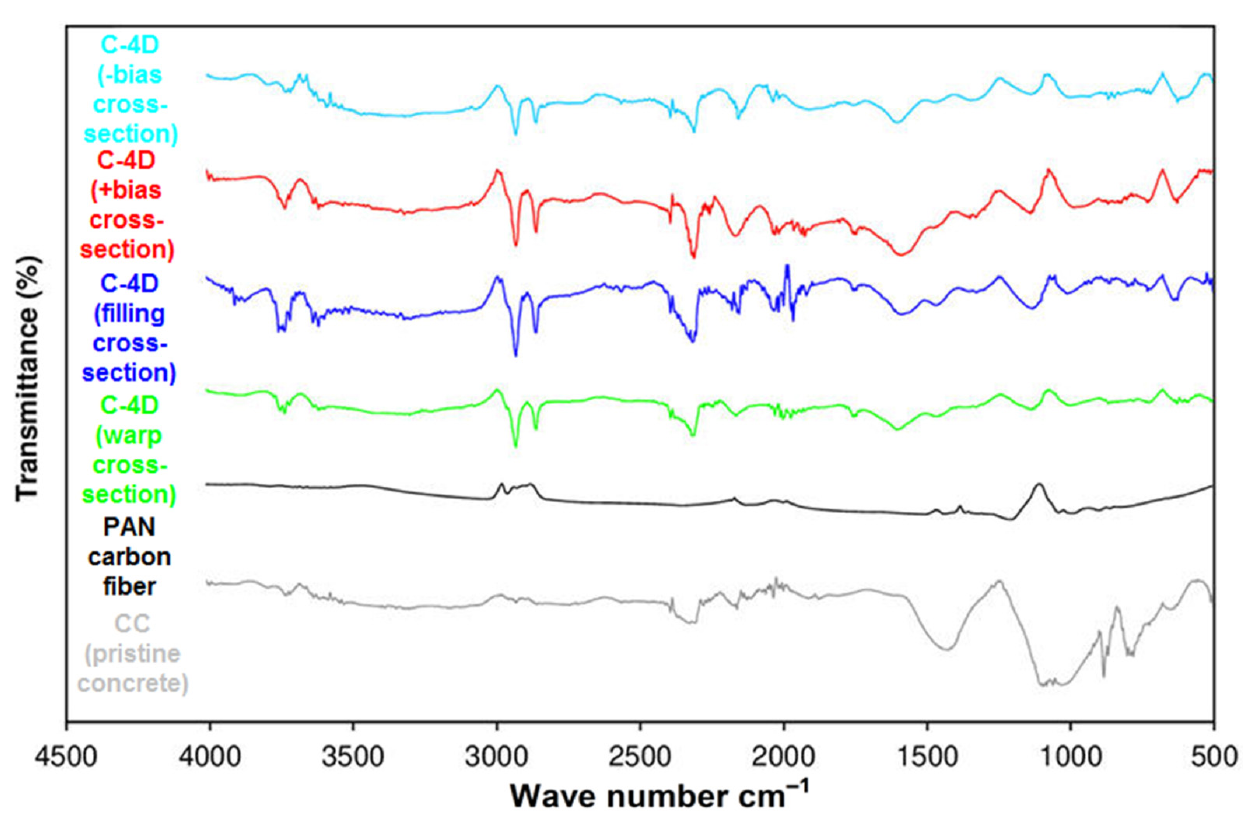
Figure 17. Fourier transform infra-red spectra of the CC (pristine concrete), PAN carbon fiber, and C-4D carbon fiber concrete composites.